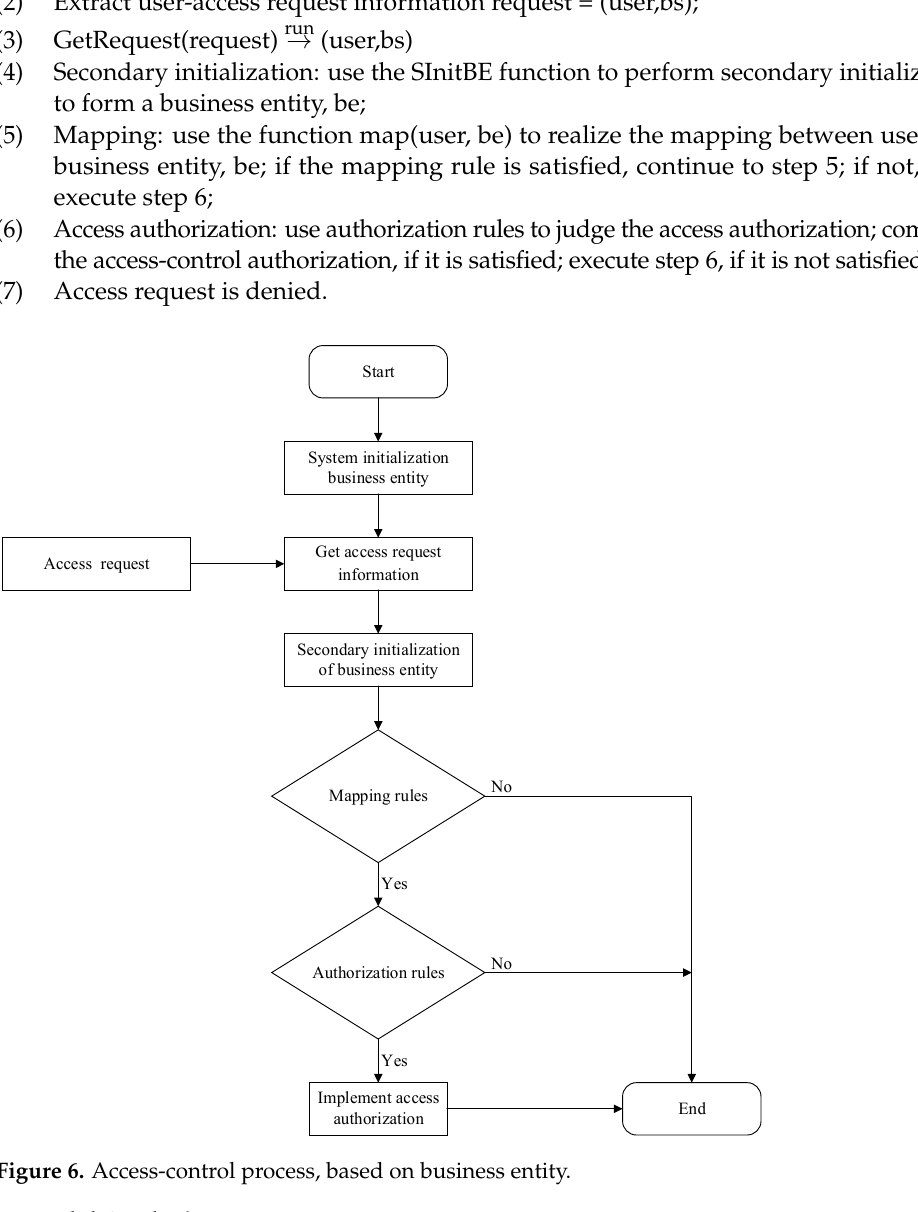
Figure 7. State transition diagram. (1) Define relevant state variables The finite-state transition system of the BE-BAC model is formally described as M = (S, S 0 , F, I), where: S denotes a finite state set, S = {S 0 , …, S n }; S 0 indicates the initial state of the model; I represents an input set; and F represents the state transition function, F: P × S → S n . This indicates that the model state changes from the current state to the next state under the driving of the input. In accordance with the above state variables, the access- control state settings are shown in Table 2.